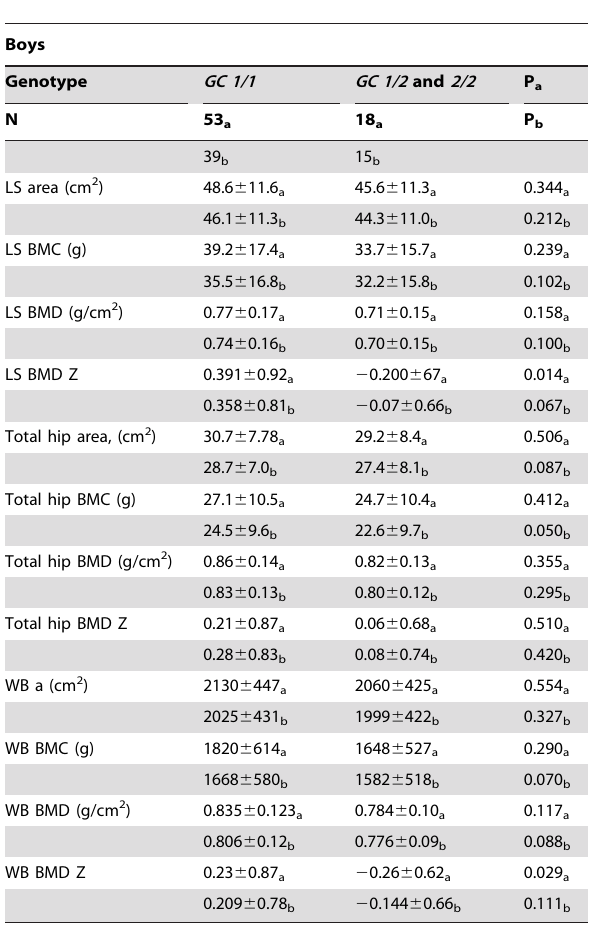
Table 4. Bone variables for genotype 1/1 and genotypes Gc 1/2 and 2/2 combined in boys measured with